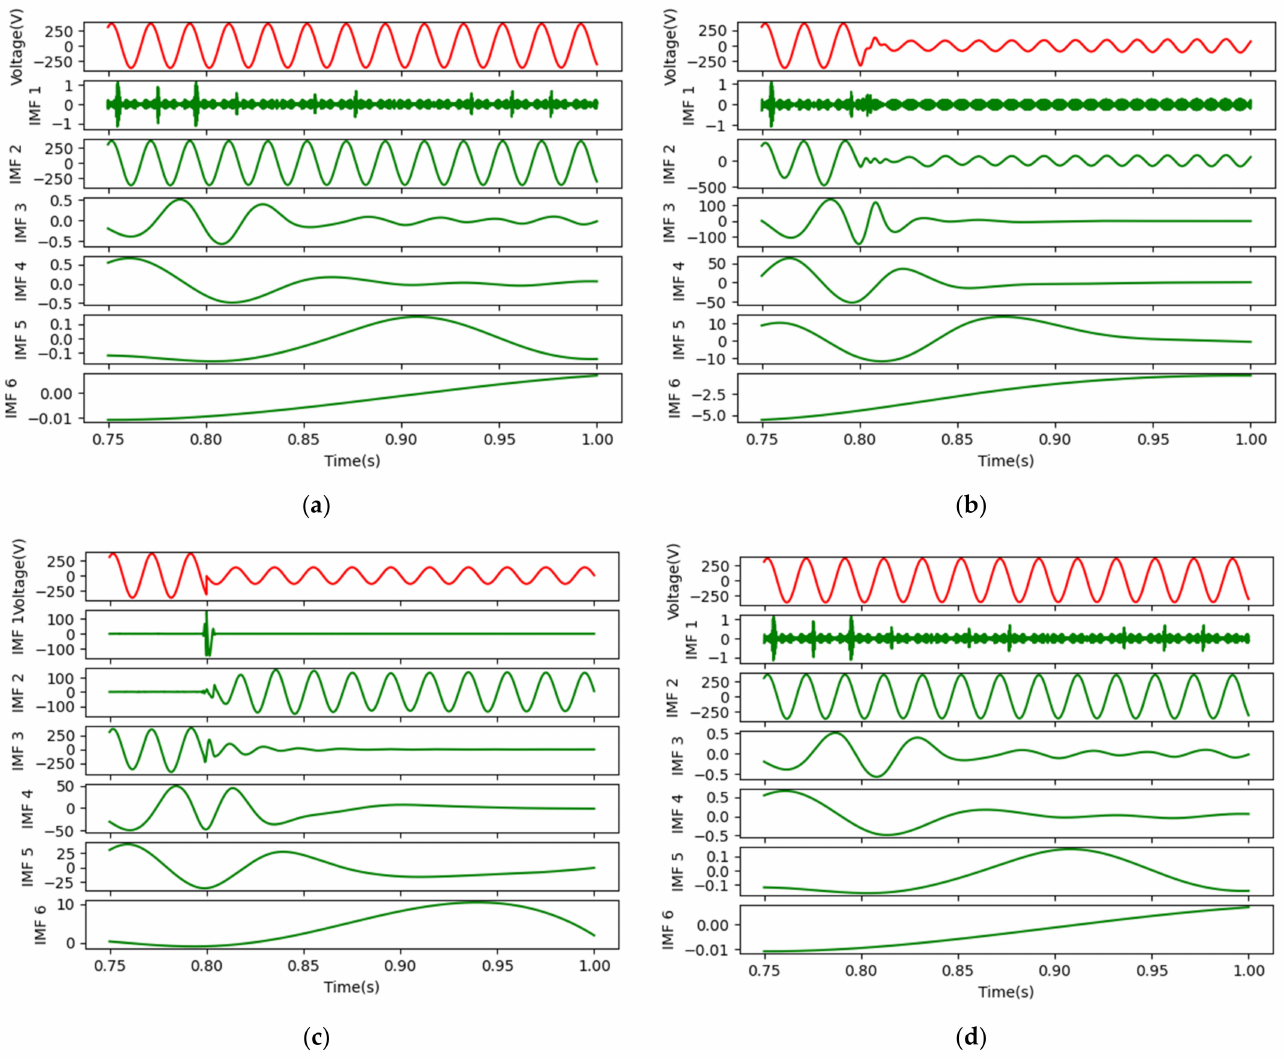
Figure 7. The results of the voltage decomposed by EMD: ( a ) The IMFs for case A; ( b ) The IMFs for case B; ( c ) The IMFs for case C; ( d ) The IMFs for case